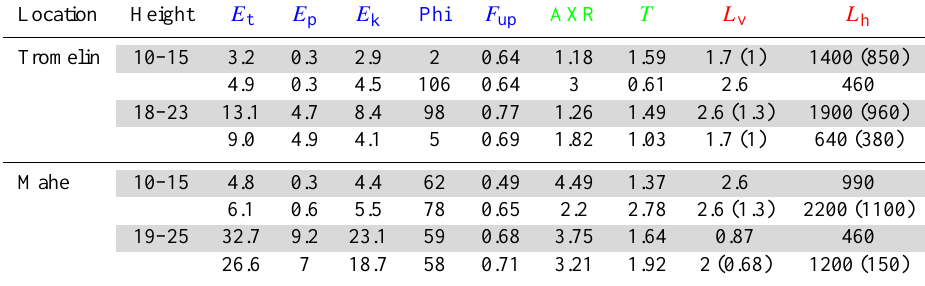
Table 2. Same as Table 1 but during 15–26 January 2002 in TC Dina period (grey) and outside of TC Dina period